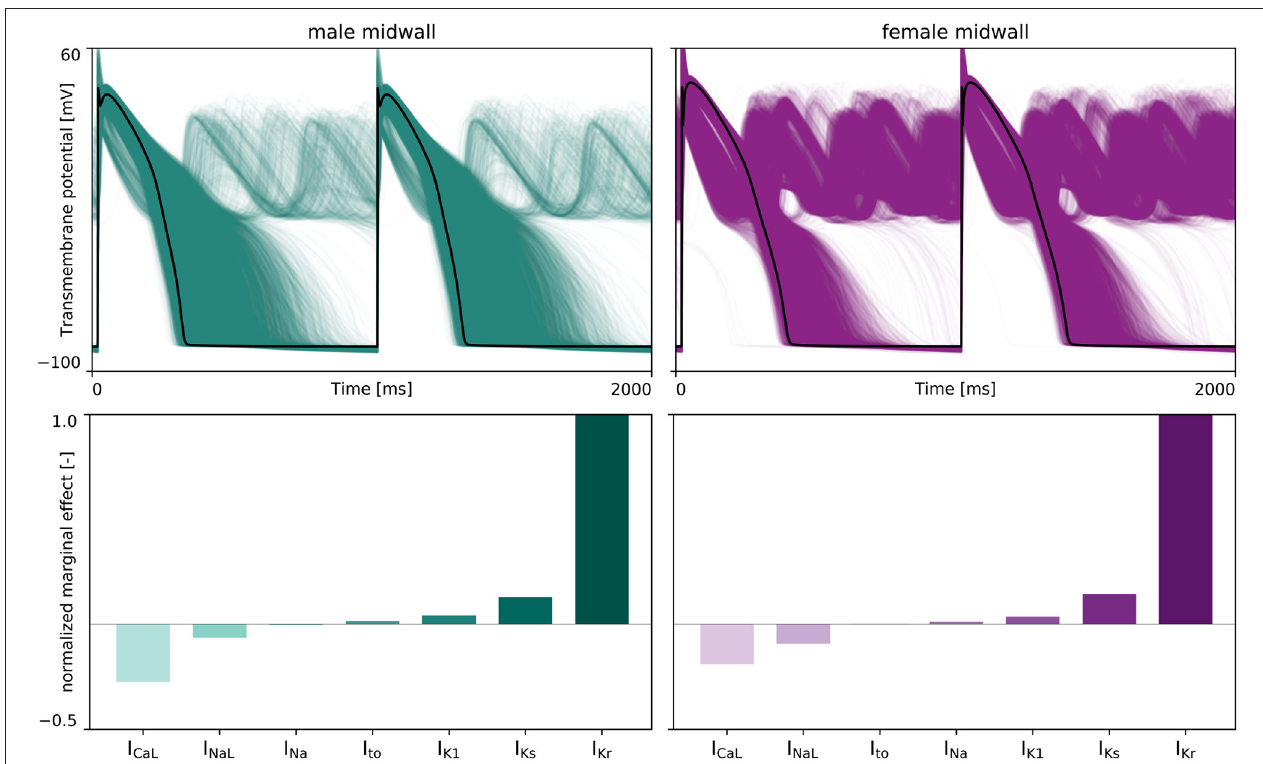
FIGURE 6 | Sex-specific sensitivity analysis drug-induced ion channel blocking on de- and repolarization abnormalities . (Upper) The effect of drug-induced ion channel blocking on the male (left) and female (right) midwall transmembrane potential evolution. The black lines represent the baseline male and female action potential, without any ion channel blocking. The green and purple lines represent the transmembrane potential evolution for 5,000 distinct I Kr , I Na , I NaL , I CaL , I Ks , I to , and I K1 ion channel blocking combinations. (Lower) Normalized marginal effects of ion channel blocking on early afterdepolarizations development in male (left) and female (right) midwall cells. Negative normalized marginal effects highlight ion channel blocking leading to anti-arrhythmic effects, whilst positive marginal effects highlight the ion channels for which drug-induced blocking can have important pro-arrhythmic consequences.